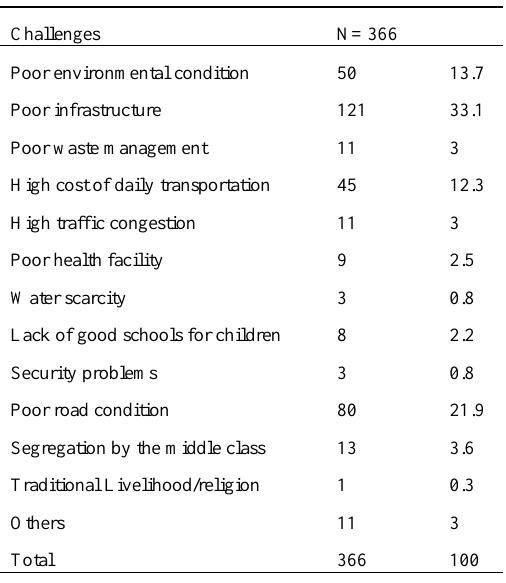
Table 5. Environmental and socio-cultural challenges in the study area.